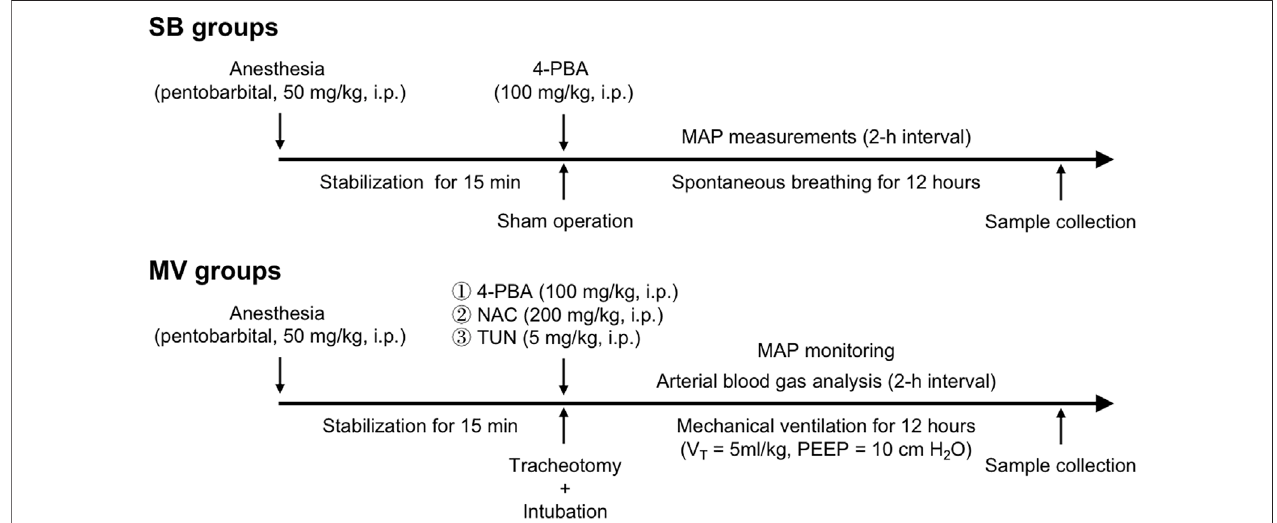
FIGURE 1 | Study design. Animals were randomly assigned to the following groups: the spontaneous breathing (SB), SB + 4-phenylbutyrate (4-PBA, ER stress inhibitor),mechanicalventilation(MV),MV+4-PBA,MV+tunicamycin(TUN,anERstressinducer),MV+N-acetylcysteine(NAC)andMV+NAC+TUNgroups.n=6per group. A single injection of 4-PBA, TUN and/or NAC was given just after the sham operation in the SB groups or prior to the onset of ventilation in the MV groups.